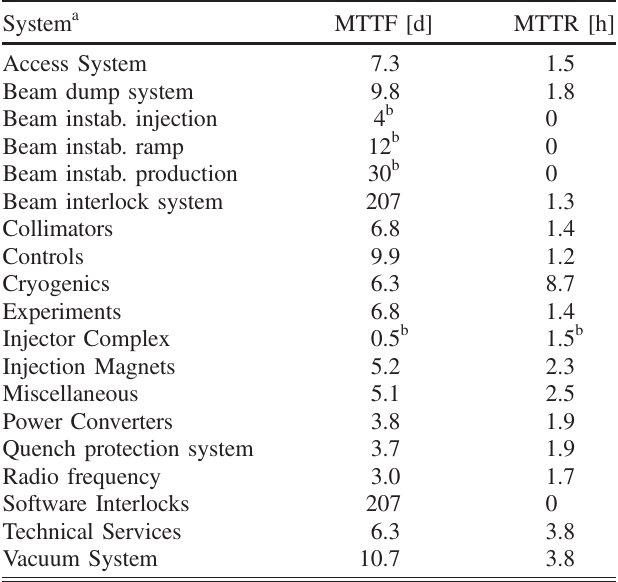
TABLE II. Beam parameters for simulation. Beam a